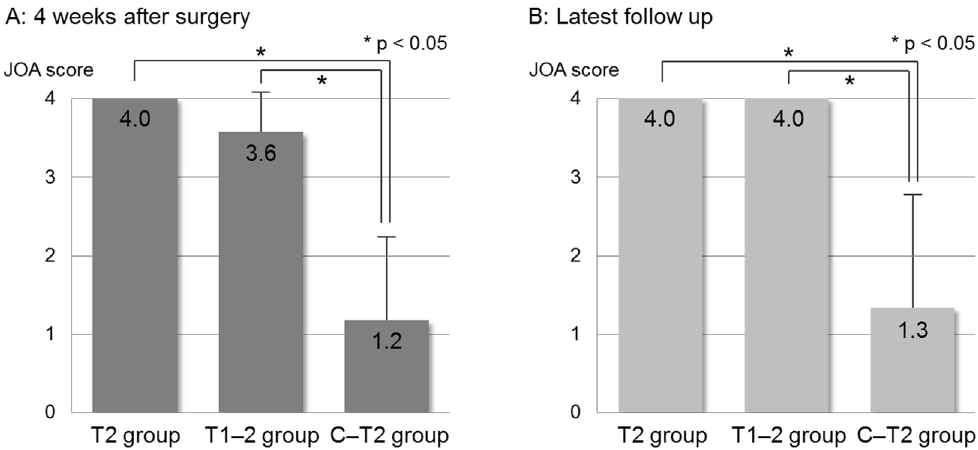
Figure 2. Postoperative mean Japanese Orthopaedic Association (JOA) scores ( + SD ) 4 weeks after surgery (A) and at the latest follow up (B). Patients who underwent upper thoracic TES with bilateral transection of the T2 nerve roots were divided into three groups: no processing of T1 and upper nerve roots (T2 group, n =3), extensive dissection of T1 nerve roots (T1–2 group, n =7), and extensive dissection of T1 and upper nerve roots (C–T2 group, n =6). The C–T2 group showed significantly more severe deterioration than the other two groups, both 4 weeks after surgery and at the latest follow up (P=0.001).